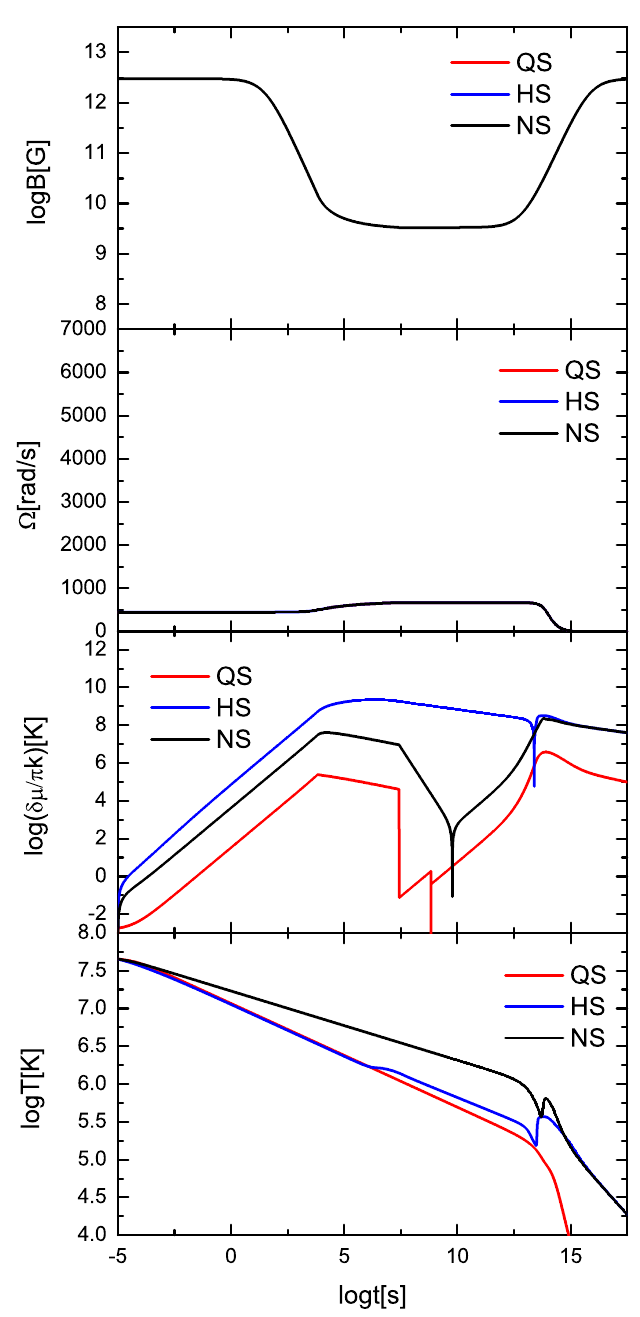
Figure 2. Surface magnetic field, spin angular frequency, chemical deviation, and surface temperature as a function of time with parameters of model 2. Pure neutron star, pure quark star, and hybrid star are represented by black line, red line, and blue line, respectively. The units of the temperature, chemical deviation, magnetic field, spin angular frequency, and time are K, K, G, rad/s, and s,